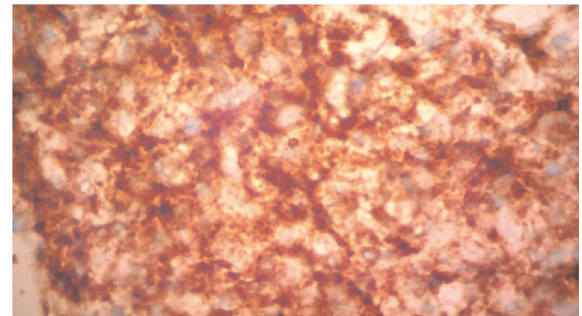
Figure 4: Vaginal mass biopsy: Hematoxylinand Eosin stain at 40X magnification.